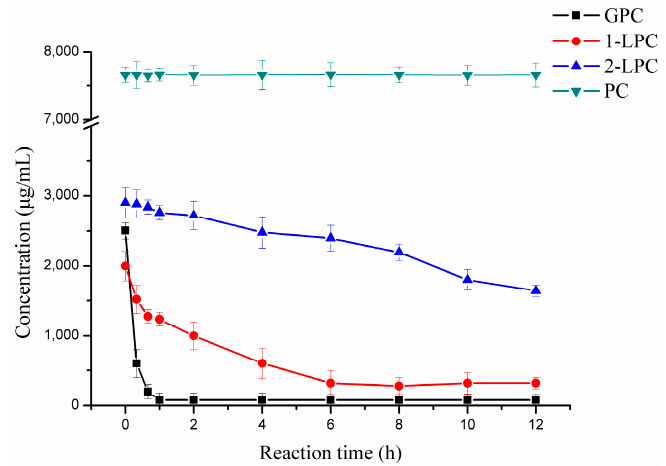
Figure 7. The hydrolysis process curve of L - α -glycerophosphorylcholine (GPC), sn 1- L - α -lysophosphatidylcholine (1-LPC), sn 2- L - α -lysophosphatidylcholine (2-LPC), and L - α -phosphatidylcholine PC by pfGDPD. Conditions: GPC, LPC or PC (24.3 mM), pfGDPD (25 U), 1 mL buffer (50 mM Tris-HCl, pH 8.5), temperature 45 °C and reaction time 12 h.